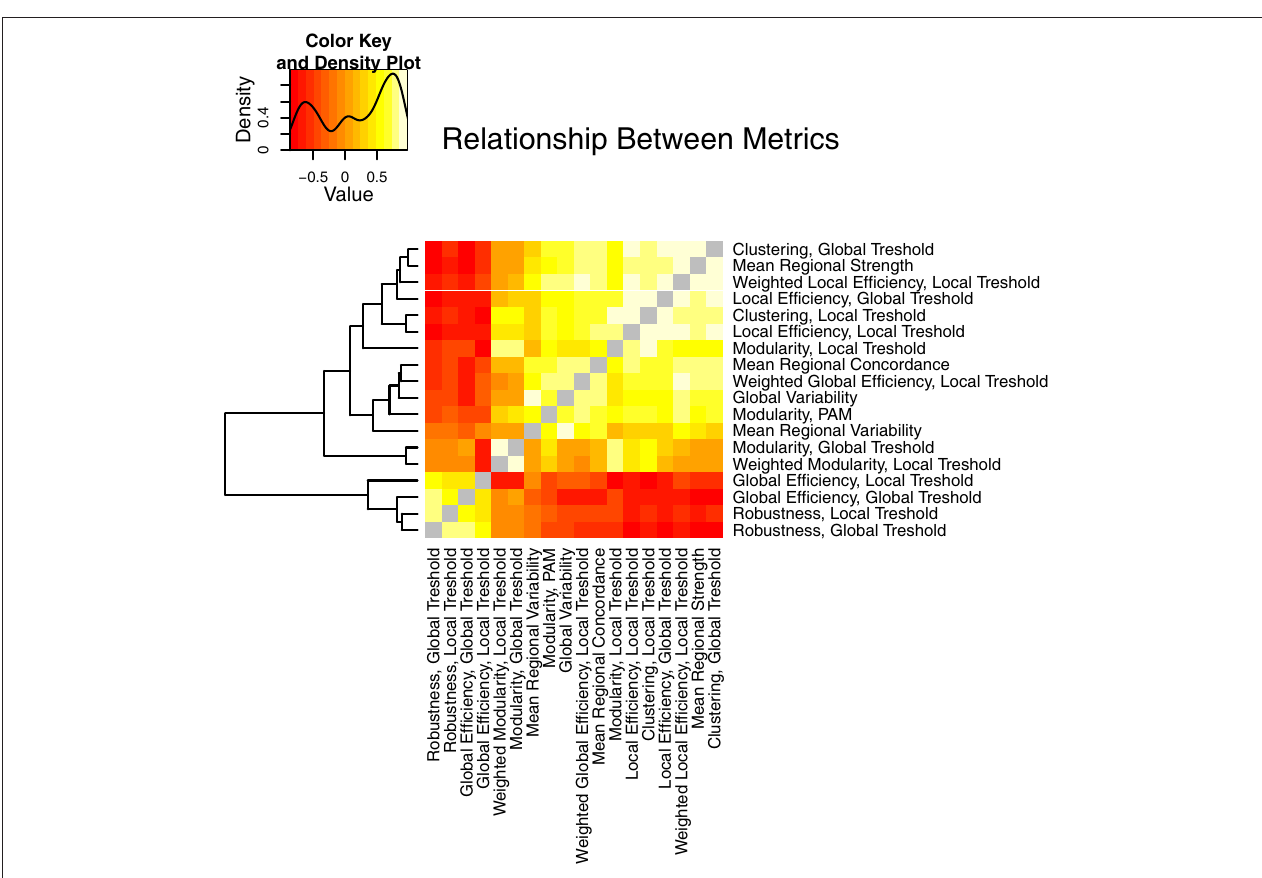
FIguRe 8 | An illustration of the relationship between the different properties of brain networks, including both graph theoretical and non-graph-theoretical metrics. The metrics from Table 1 are correlated between all the subjects in the study and presented as a heat map, with the color value corresponding to the Pearson’s correlation coefficient. The layout is organized by complete linkage hierarchical clustering, according to the dendrogram shown at the left of the